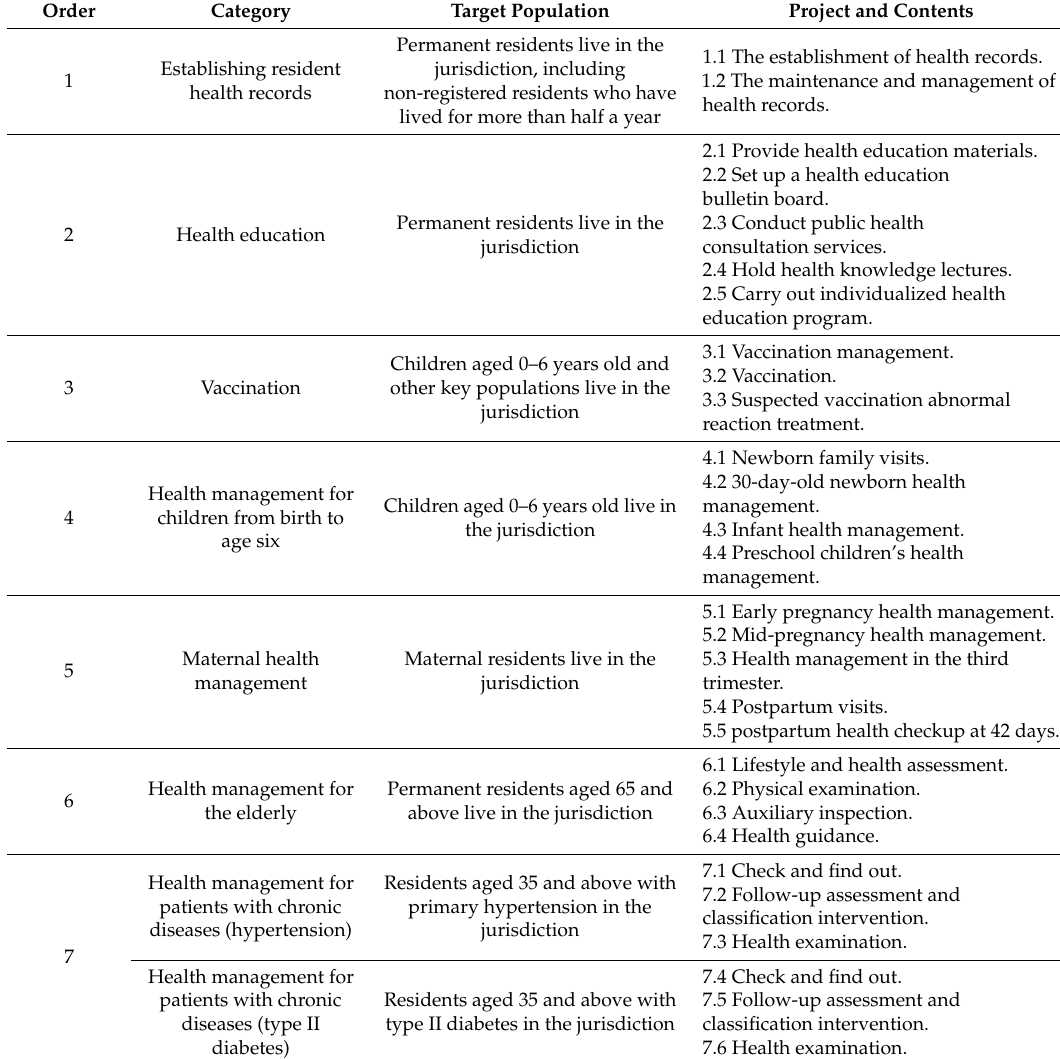
Table A1. List of China’s National Basic Public Health Service Project in